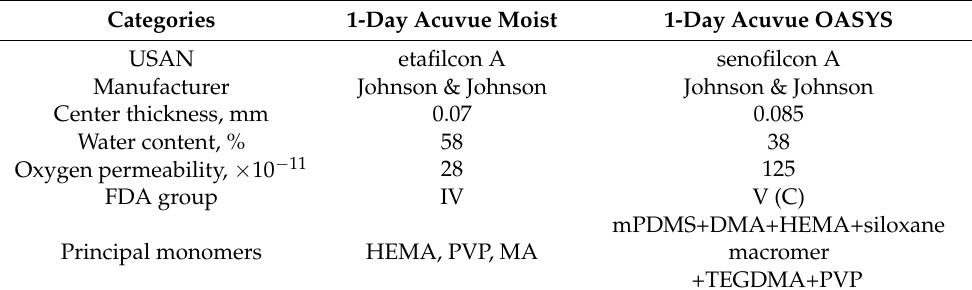
Table 1. Properties of contact lenses